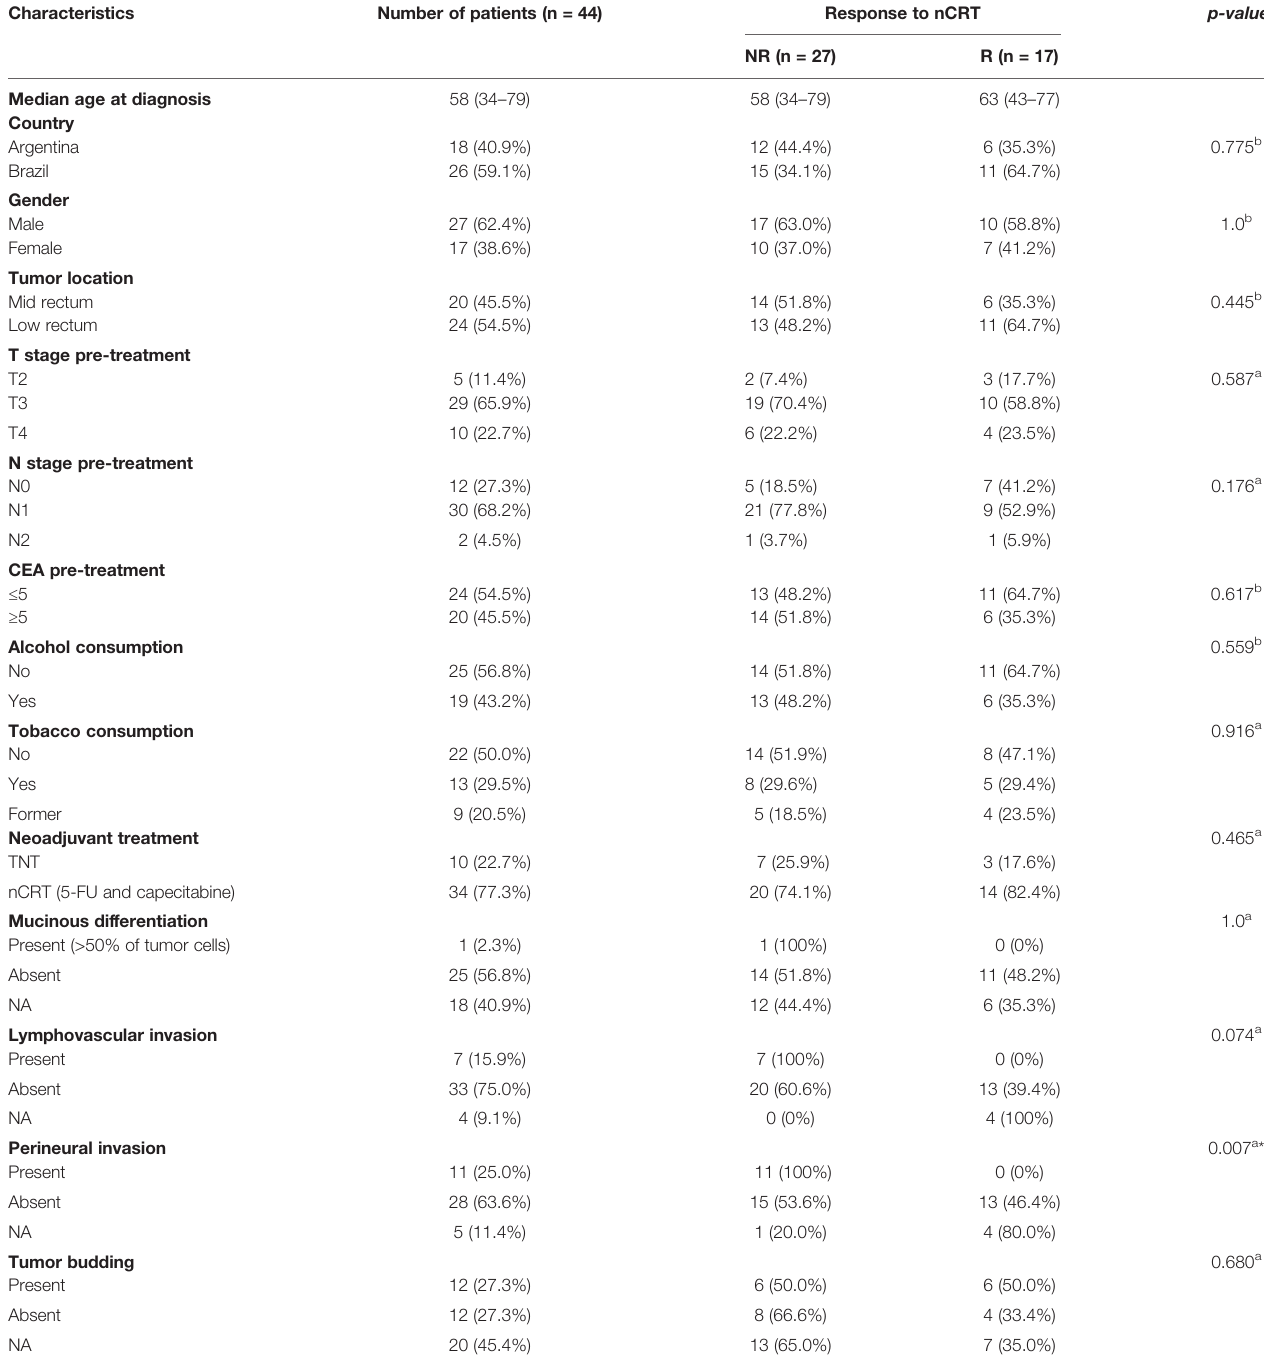
TABLE 1 | Clinicopathological and lifestyle characteristics of LARC patients from Argentina and Brazil enrolled in this